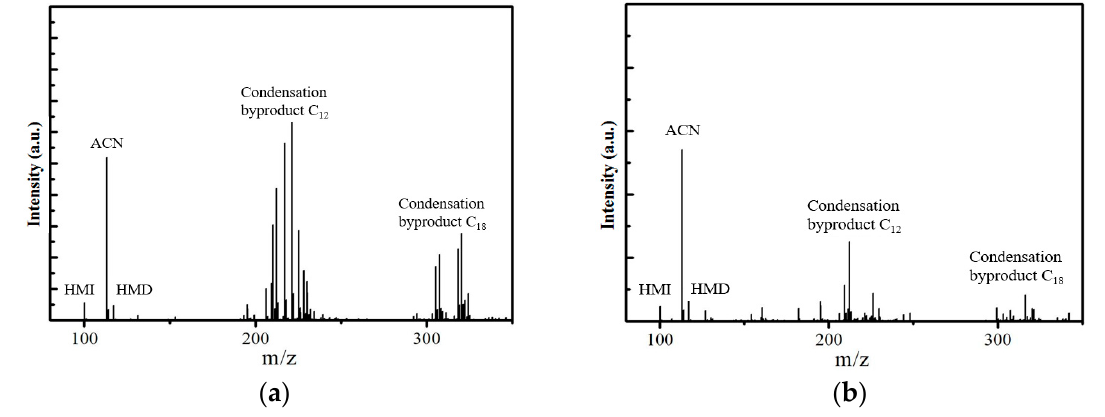
Figure 5. Mass spectra of ( a ) Ni CR /SiO 2 and ( b ) Ni DR /SiO 2 .